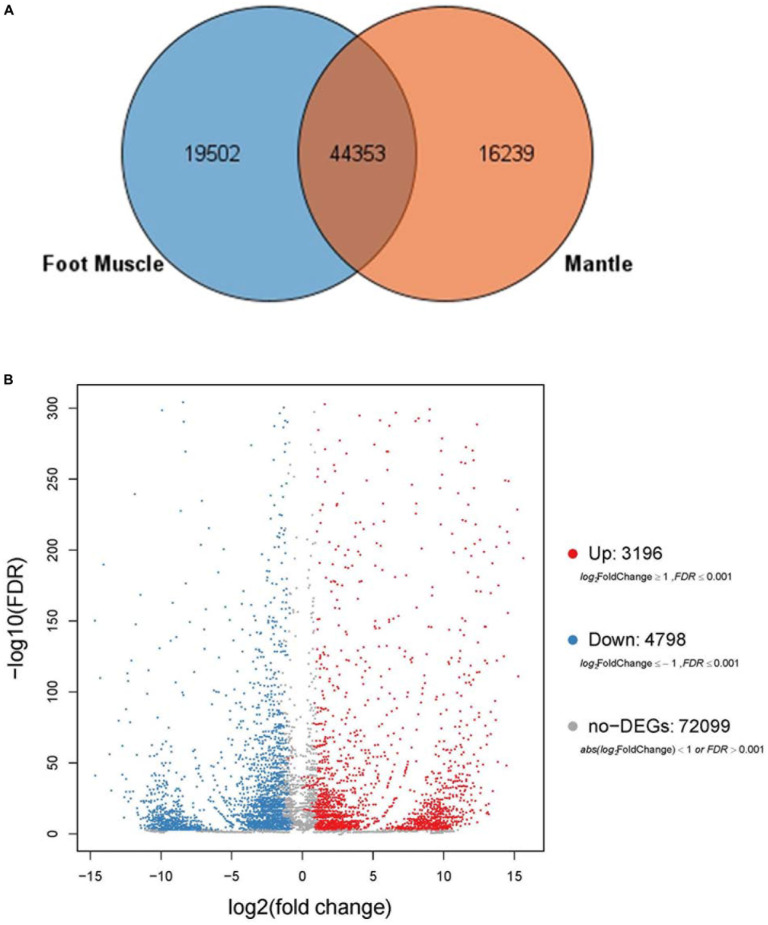
(A) Venn diagrams for number of comparisons of transcripts among foot muscle and mantle tissue. (B) Volcano plot of differentially expressed genes (DEGs) in foot muscle and mantle from C. tritonis.